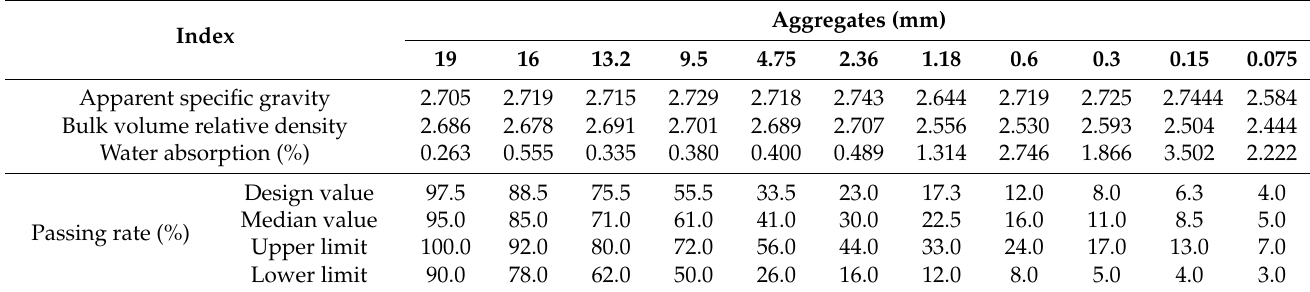
Table 2. Physical characteristics of aggregates.